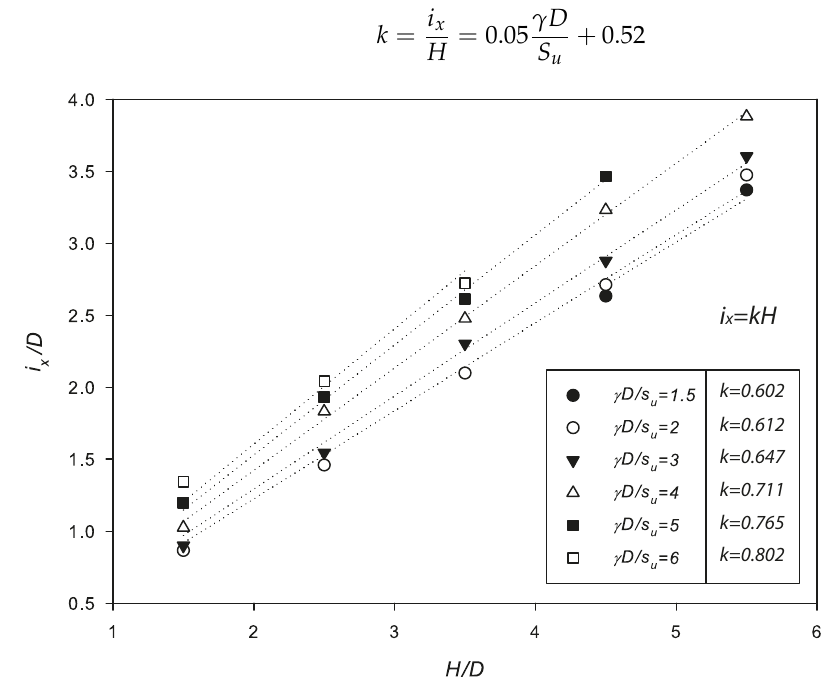
Figure 19. Complete results of regression analysis, and resulting proportionality constants ( k ).